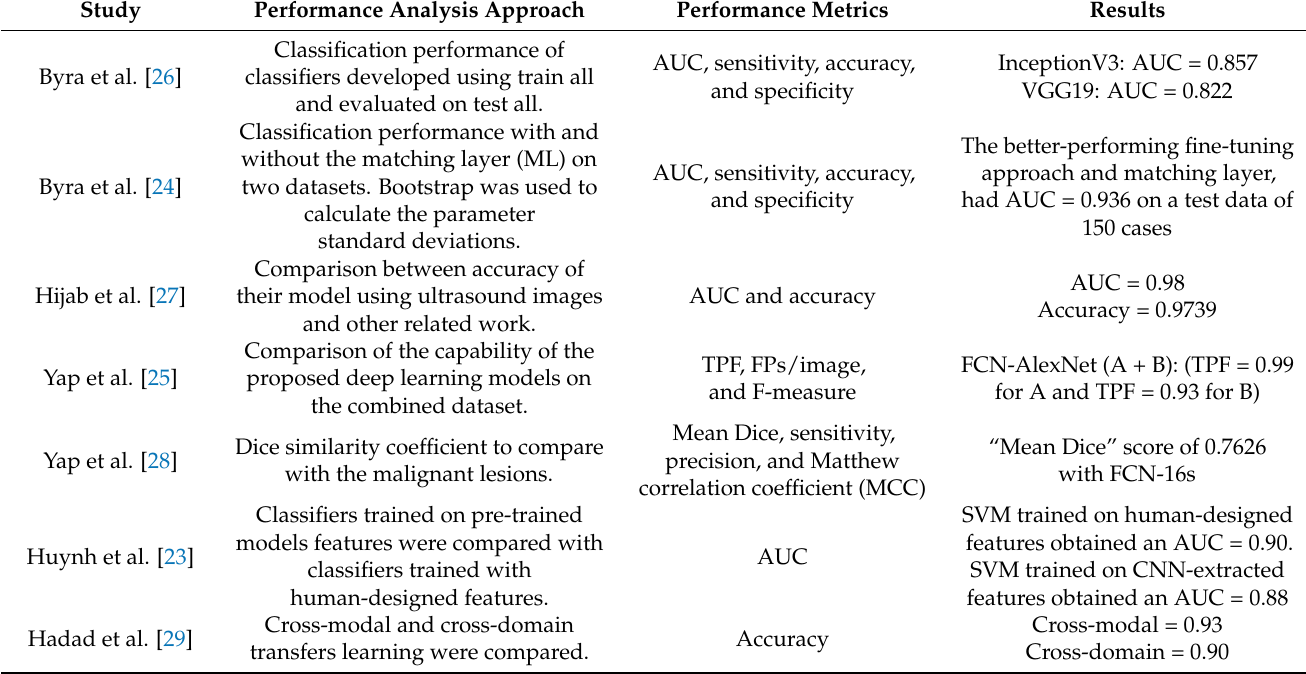
Table 2. Performance analysis criteria in transfer learning for diagnosing breast cancer from ultrasound images. AUC, area under curve; TPF, true positive fraction; FPs/image, false positives per image; F-measure, weighted harmonic mean of recall and precision; FCN, fully convolutional network; MCC, Matthew correlation coefficient; SVM, support vector machine; CNN, convolutional neural